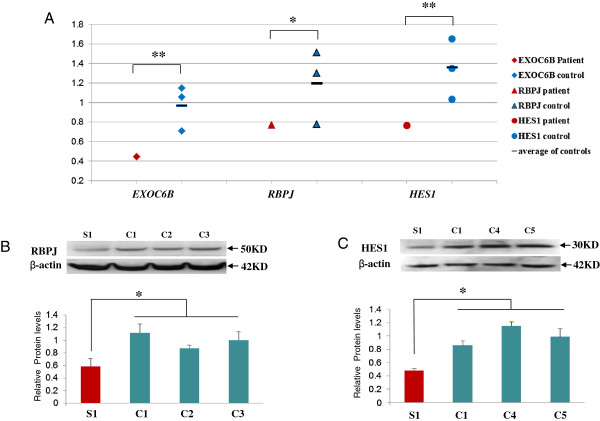
mRNA and protein expression in Subject 1 and control lymphoblast cells. A. Scatter graph of mRNA expression of EXOC6, RPJB and HES1in lymphoblasts. Values for EXOC6, RPJB and HES1 mRNA expression were normalized to the corresponding ß-actin mRNA levels. The results derived from at least three sets of samples and the mean level of each sample is represented in the graph, horizontal bar is an average value between three controls. The difference between the study sample and the average of the controls has been evaluated by student t-test (*, p < 0.05; **, P < 0.01). B. RBPJ protein expression. C. HES1 protein expression. C1-C5 indicate control samples from the lymphoblasts, S1 indicate study sample from Subject1. Cell lysates were analyzed by SDS-PAGE and immunoblotting with membrane probed for RBPJ, HES1 and ß-actin, Values for RBPJ and HES1 expression were normalized to the corresponding ß-actin levels. The results derived from at least three sets of samples and the mean value of each sample is represented in the bar graph. The difference between Subject1 and the average of three controls has been evaluated by student t-test (*, p < 0.05).